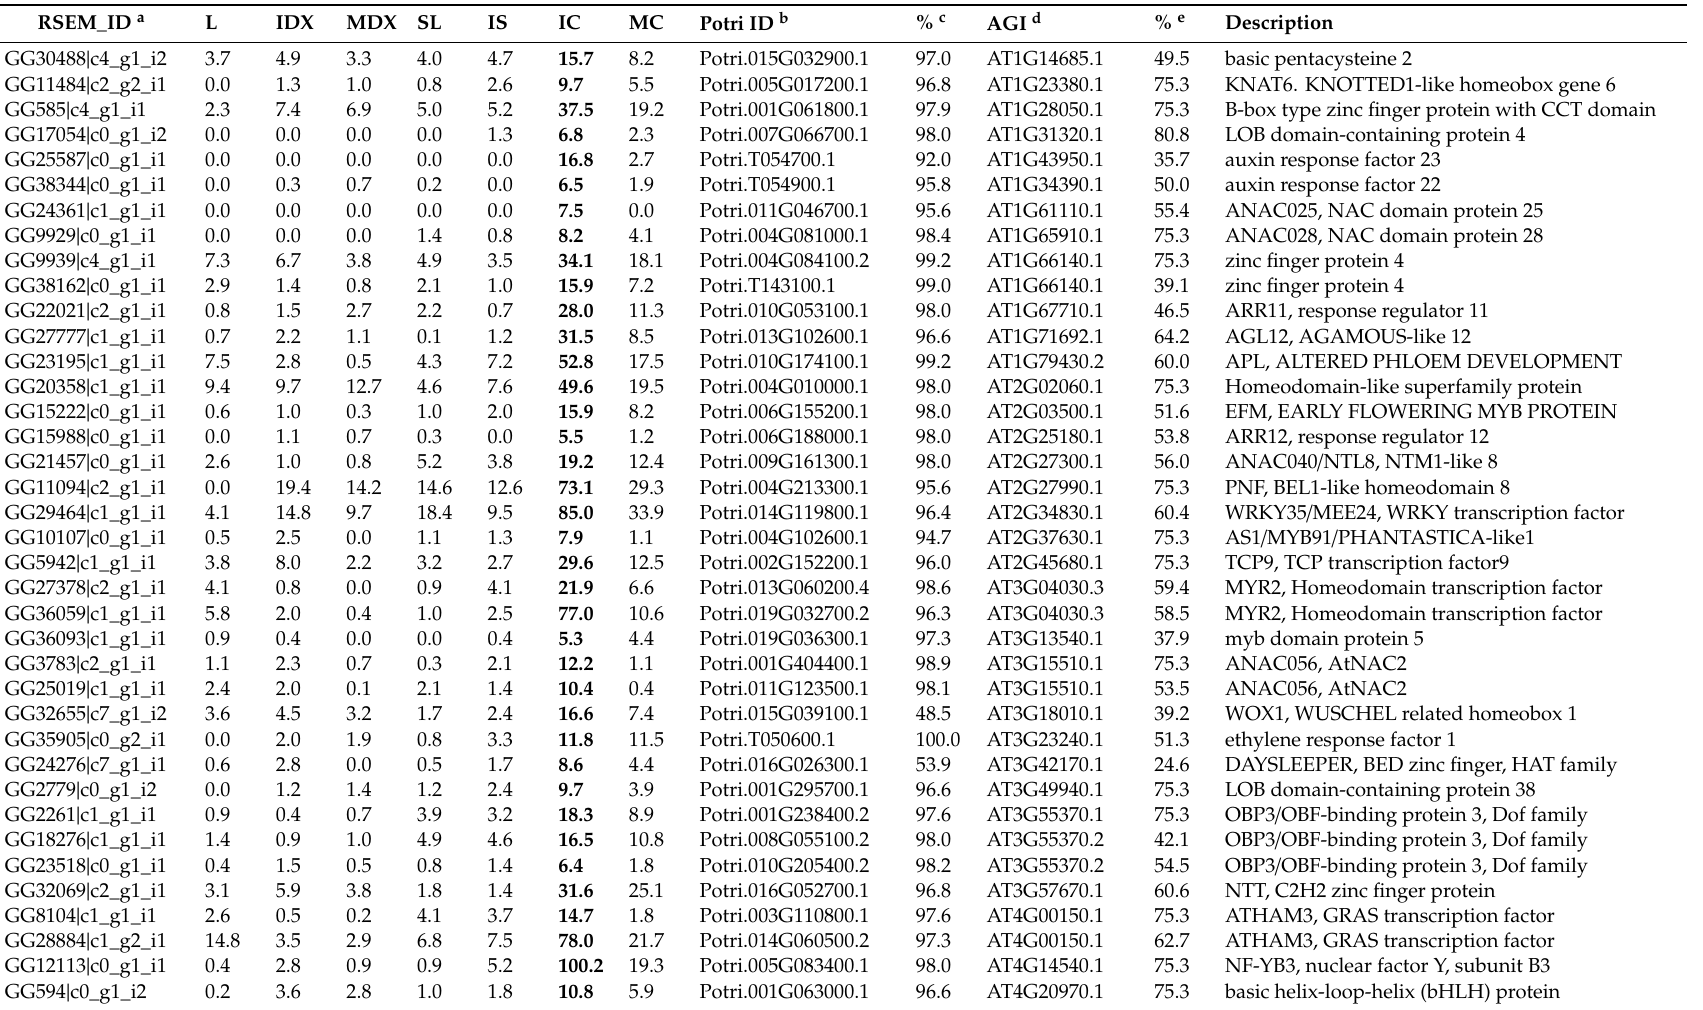
Table 2. Transcriptional regulators preferentially expressed in the intermediate cambium (IC)